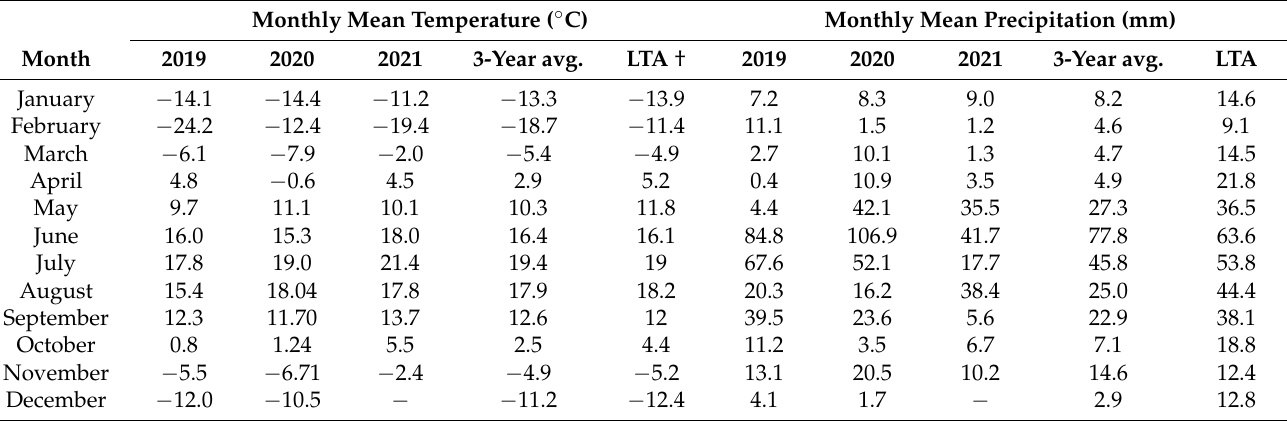
Table 2. Monthly mean air temperature and precipitation at Clavet, (Dark Brown soil zone) Saskatchewan, Canada over 3 years (2019 to